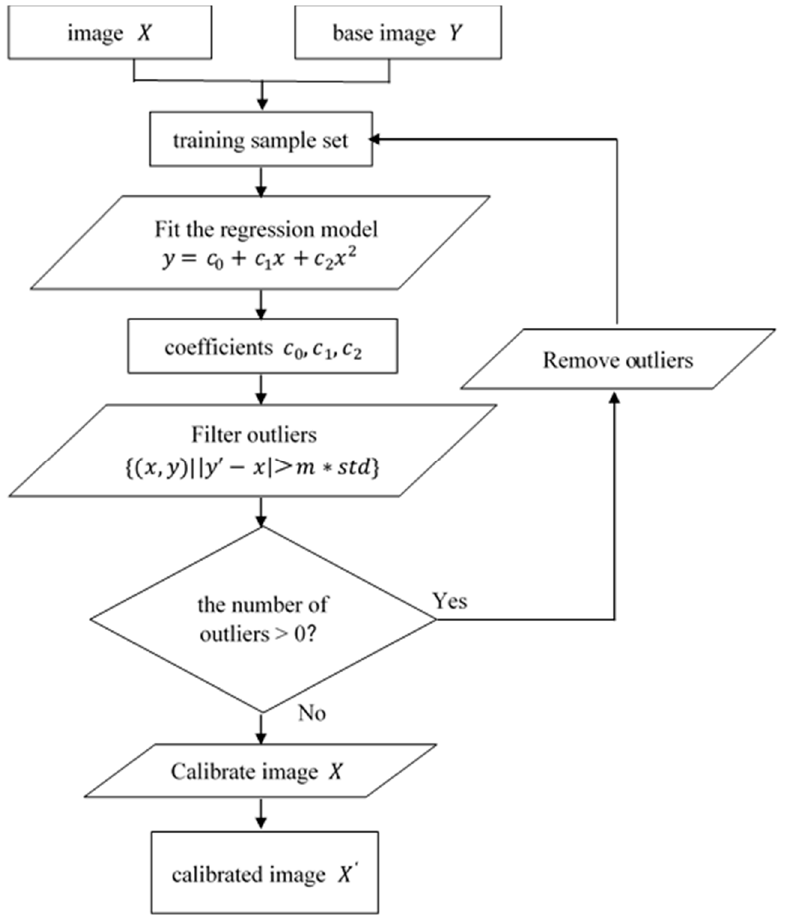
Figure 3. Calibrating DMSP annual composites.